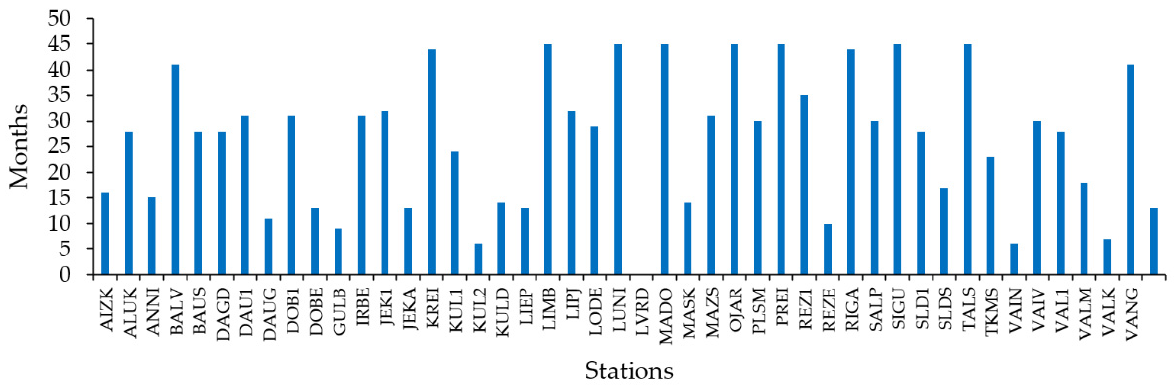
Figure 1. Data input rate of Latvian CORS stations.